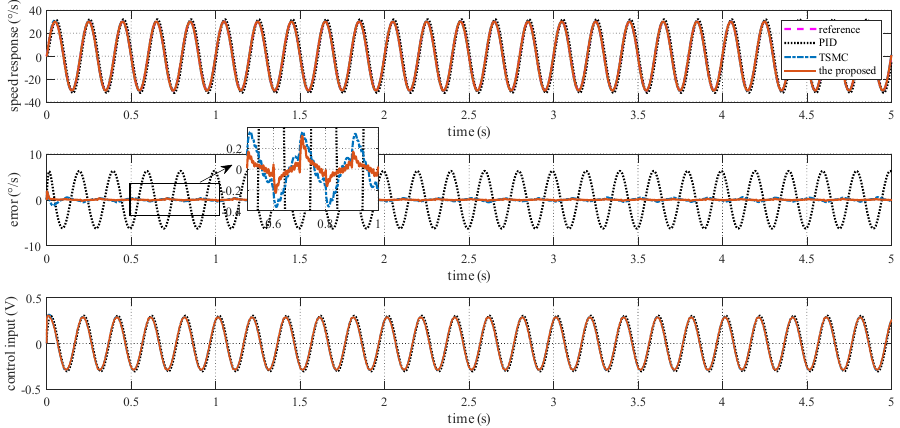
Figure 6. Simulation response curves to a sinusoidal reference signal with 30 ◦ /s amplitude and 5 Hz